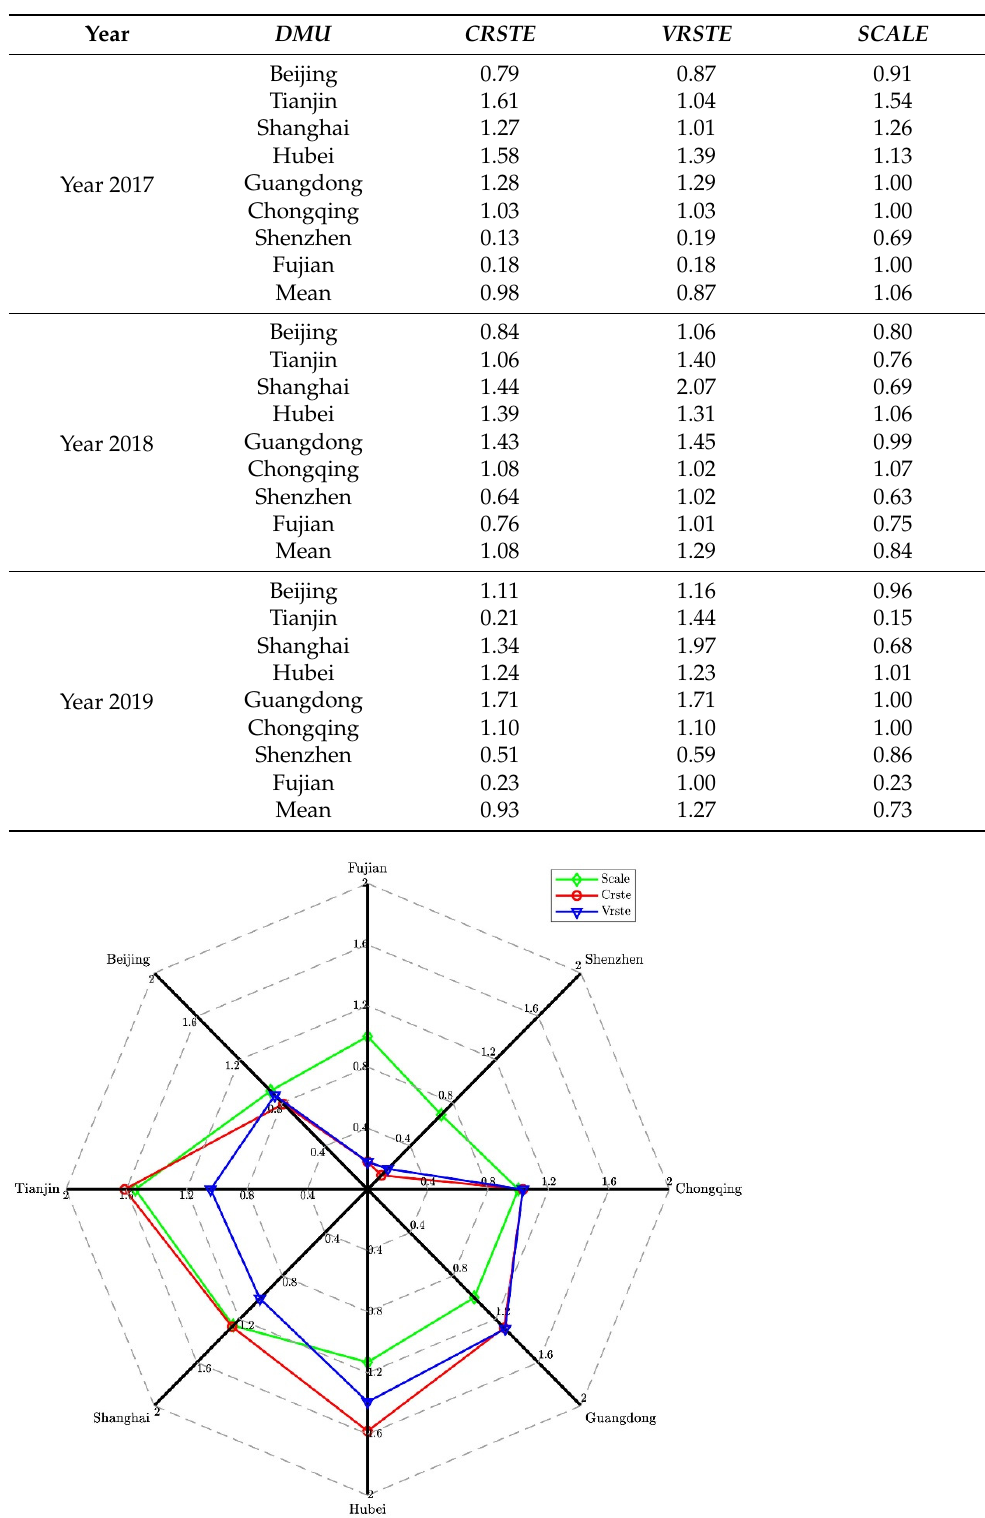
Figure 4. DEA efficiency measurement of the carbon market in 2018.